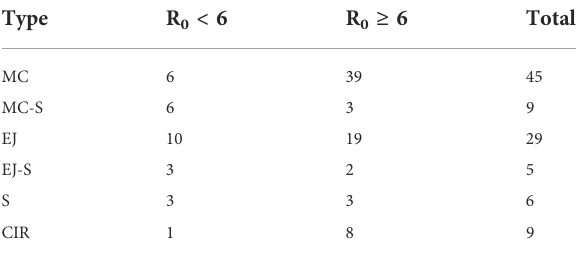
TABLE 3 Number of events with R 0 < 6 and R 0 ≥ 6 for different solar